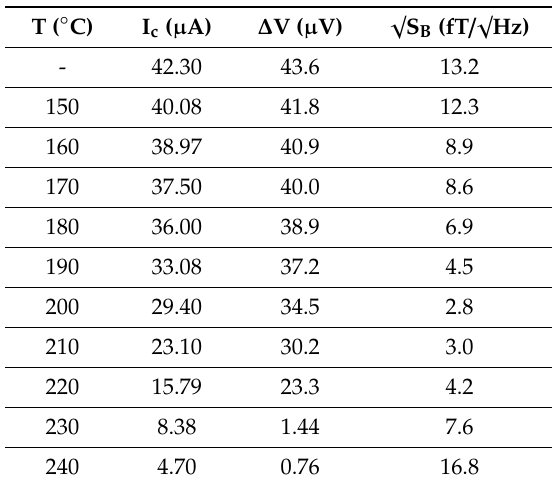
Figure 2. Critical current and voltage swing of a SQUID magnetometer as a function of the annealing temperature measured at liquid helium temperature. The values were normalized to the initial value without any annealing. The annealing time for each temperature was 30 min. The solid black line is just an eye-guide line. Table1. Mainsuperconductingquantuminterferencedevice(SQUID)parametersfordi ff erentannealing temperatures measured at liquid helium temperature. Each annealing step lasts 30